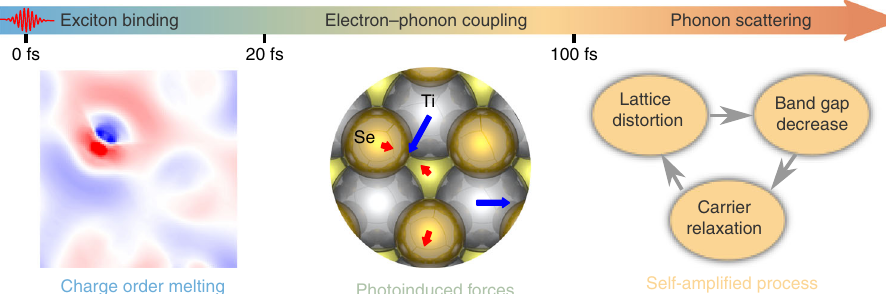
Fig. 1 Schematic of atomic processes in photoexcited 1T-TiSe 2 . The laser pulse melts charge order within 20 fs, producing the forces that trigger the ionic movements. The self-ampli fi ed dynamics is assisted by electron – phonon couplings after initial